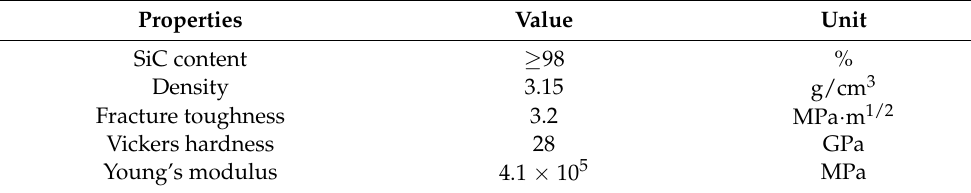
Figure 4. Photographs of the experimental setups. ( a ) Longitudinal ultrasonic tool holder. ( b ) Longitudinal–torsional coupled ultrasonic tool holder.